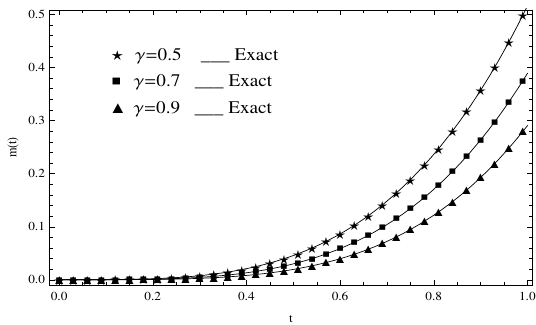
øøøøøøøøøøøøøøøøøøøøøøøøøøøøøøøøøø